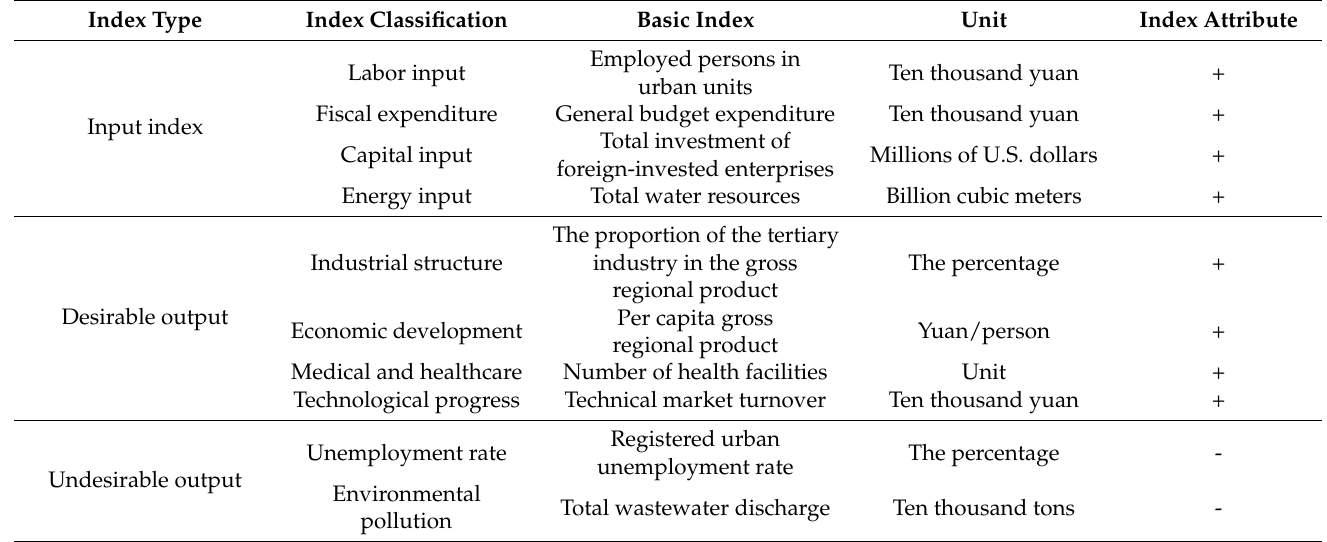
Table 1. The Yellow River Basin Province/City high-quality development efficiency index